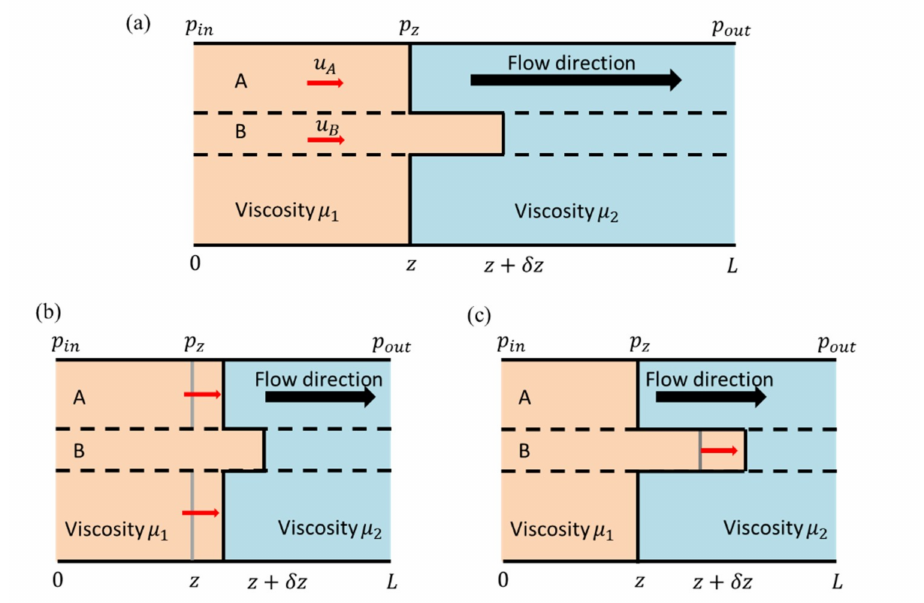
Figure 2. The explanation for Sa ff man–Taylor instability. The solution flows from left to right in the figures. ( a ) The setup situation and the results under ( b ) a hydrodynamically stable condition ( µ 1 > µ 2 ) and ( c ) a hydrodynamically unstable condition ( µ 1 < µ 2 ), i.e., Sa ff man–Taylor instability. p represents pressure at the position z